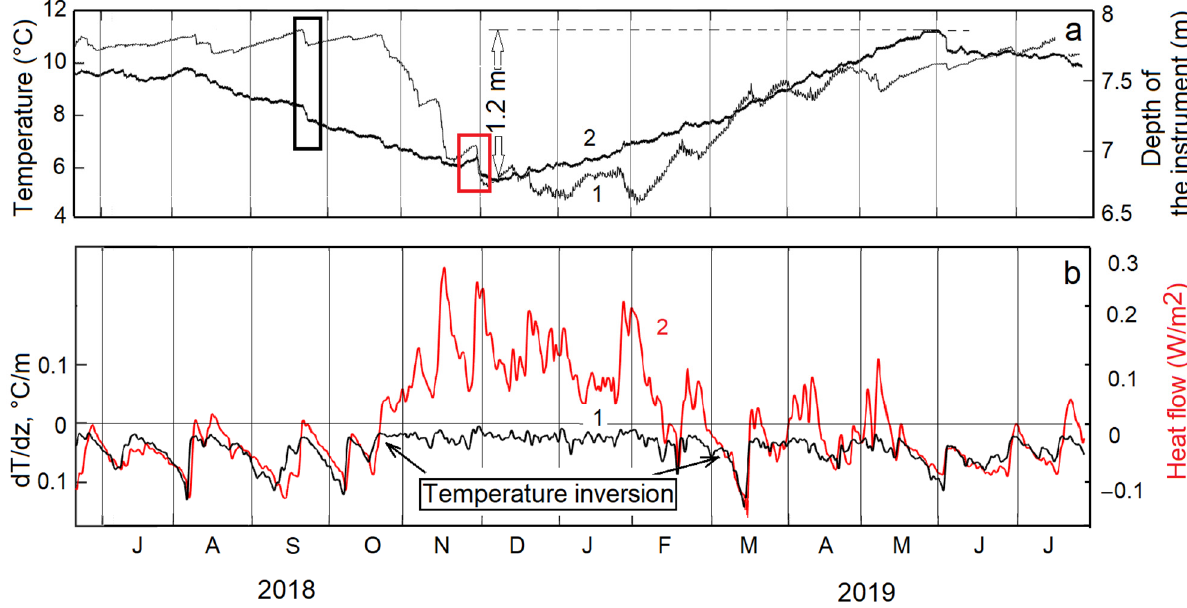
Figure 9. ( a ) Annual series of temperature fluctuations (1) of bottom sediments and (2) the level of Lake El Sol in the area of the floating meteorological station. Moments of a sharp change in the measured characteristics are marked by black and red rectangles. ( b ) Vertical gradient of water temperature between the bottom and 1 m above the bottom (9 and 8 m depth) (1). The red curve (2) is the calculated heat flux across the water-bottom sediment interface (positive values are heat flux from bottom sediments to water layers).